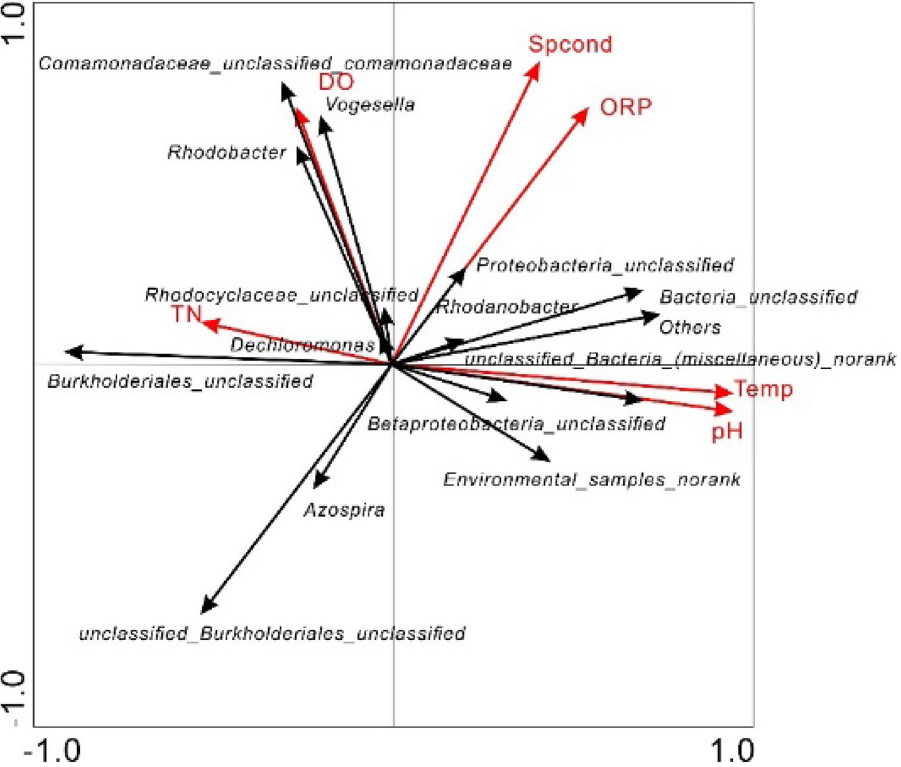
Figure 7. Relationships between denitrifying bacterial community structures and environment